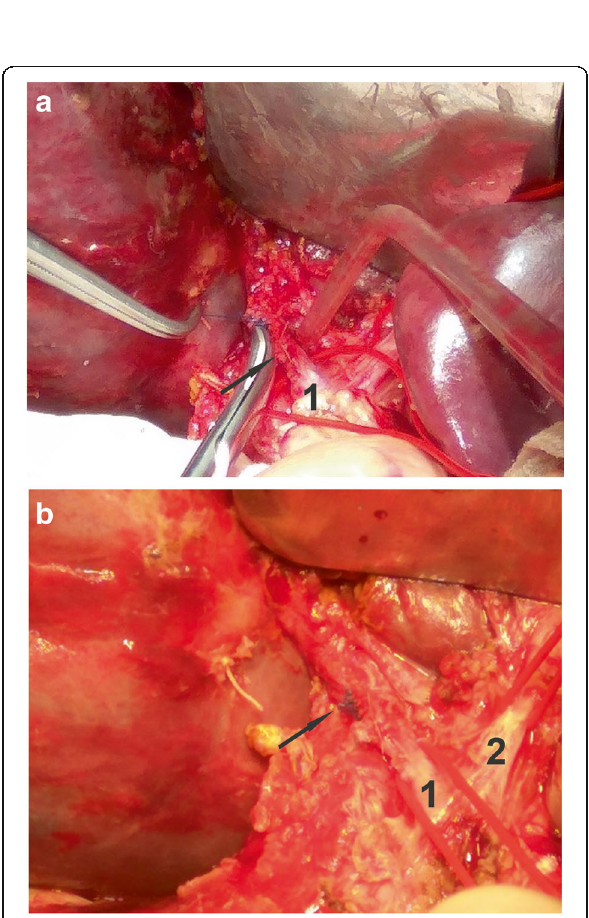
Fig. 4 Photograph illustrating erosive defect of right hepatic artery after suturing. a The area of erosive defect of right hepatic artery is marked by an arrow; the turnstile is placed under the artery (marked by 1). b Sutured right hepatic artery (suture line marked by the arrow): 1 - right hepatic artery; 2 - left hepatic artery on the